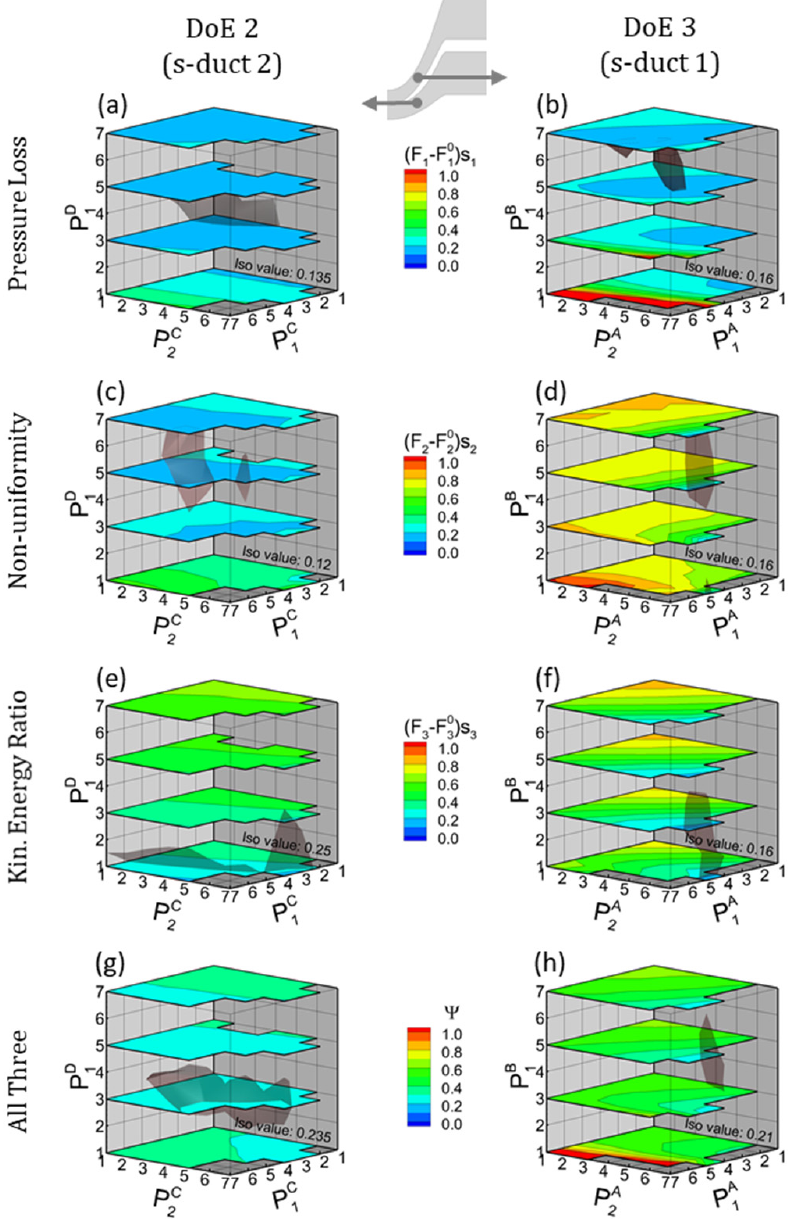
Figure 24. Model 2 (DoE 2 and DoE 3) system responses in all design objectives. Plotted outputs include: Pressure loss ( a , b ), non uniformity ( c , d ), kinetic energy ratio ( e , f ), and the multi-objective function ( g , h ).